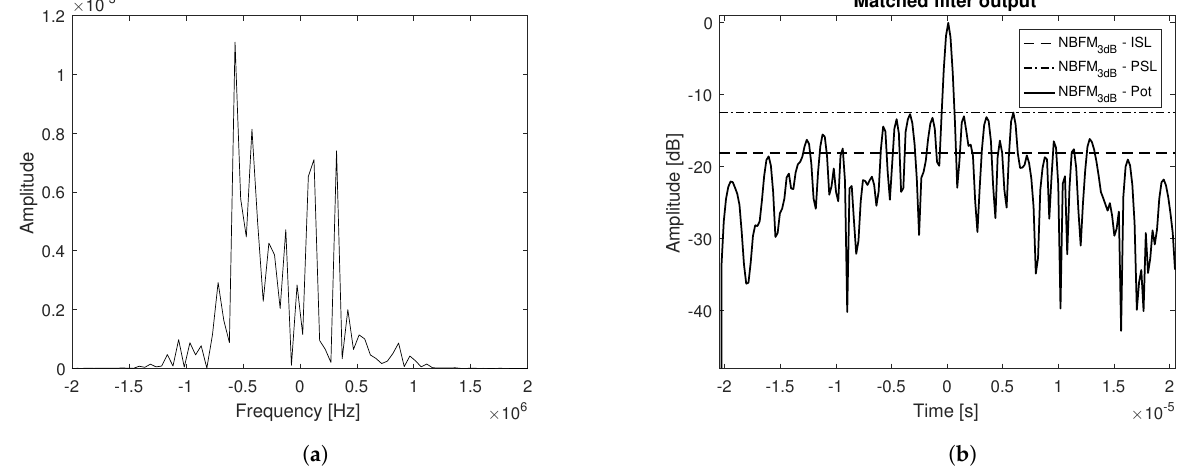
Figure 9. ( a ) Power Spectral Density (PSD) and ( b ) matched filter output power of the loopback signal, considering a narrowband frequency modulated random transmit signal (NBFM 3dB